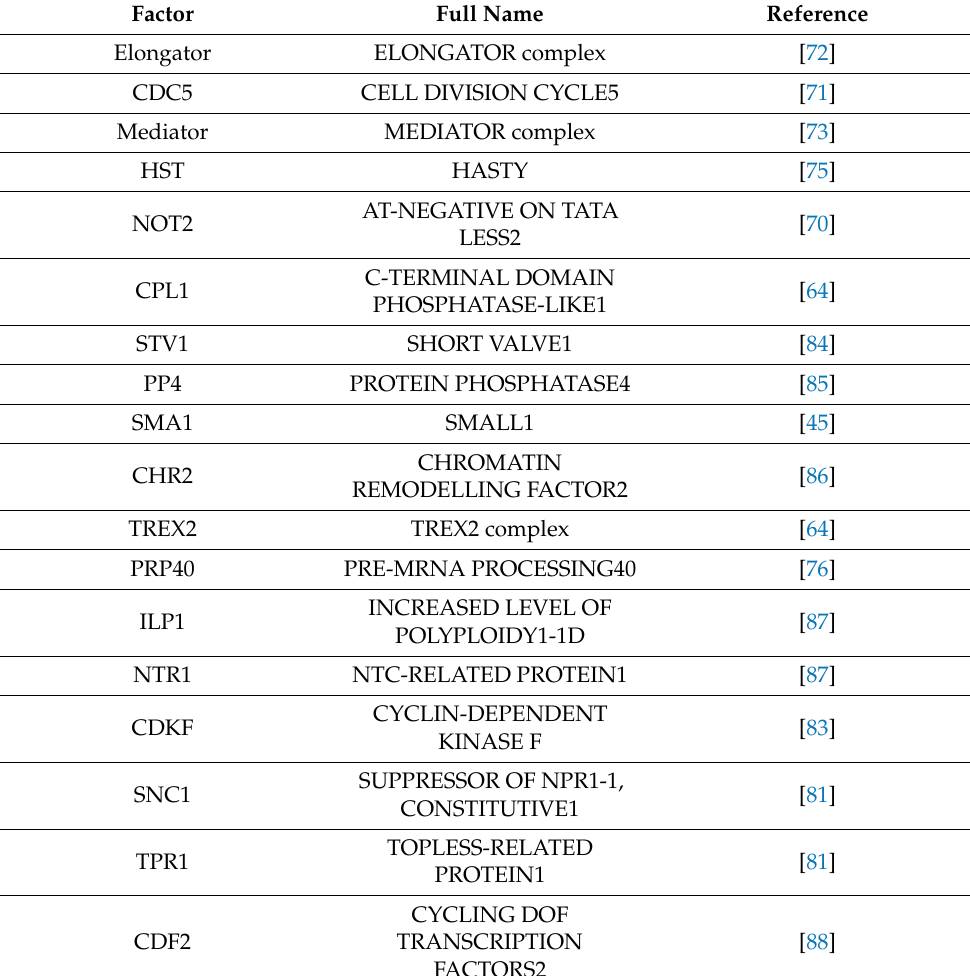
Table 1. List of known factors involved in the regulation of MIR genes